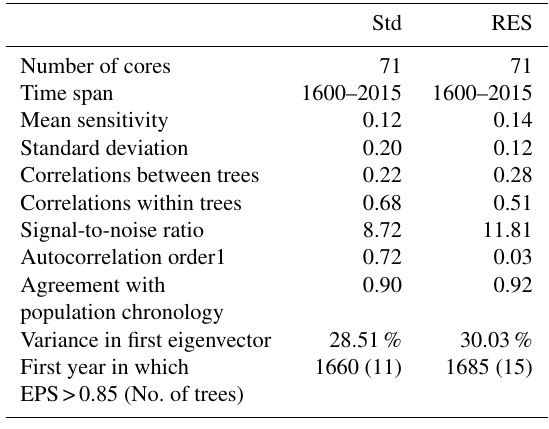
Table 1. Major statistical characteristics for the chronology of Pi- nus koraiensis on Laobai Mountain.